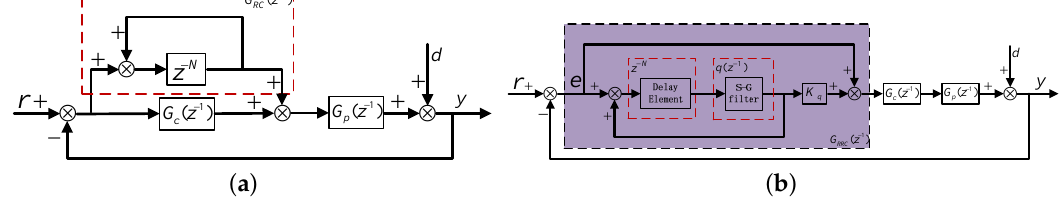
Figure 4. Structural diagram of repetitive controller in discrete domain: ( a ) IRC; ( b ) RRC.